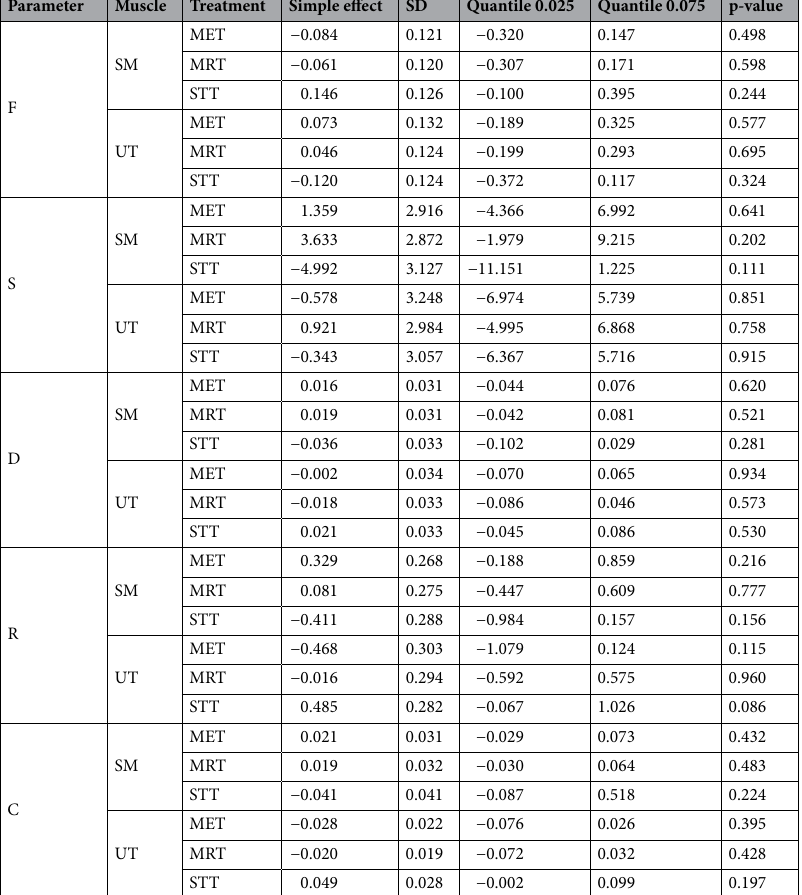
Table 6. Results—changes in muscle properties for each group from pre- to post-intervention in each session (between-participant difference). F = Oscillation Frequency; S = Dynamic Stiffness; D = Logarithmic Decrement; R = Mechanical Stress Relaxation Time; C = Ratio of deformation and Relaxation time; SM = superficial masseter muscle; UT = upper trapezius muscle; SD = standard deviation.